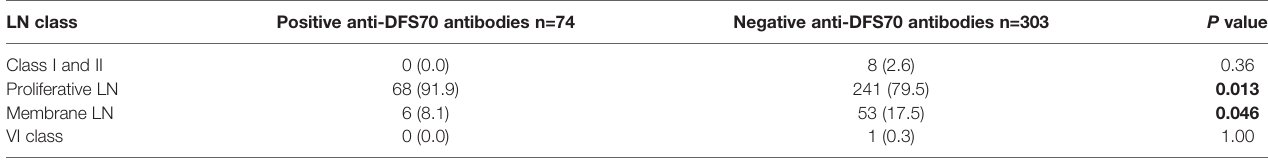
TABLE 3 | Distribution of anti-DFS70 antibodies in different LN class.